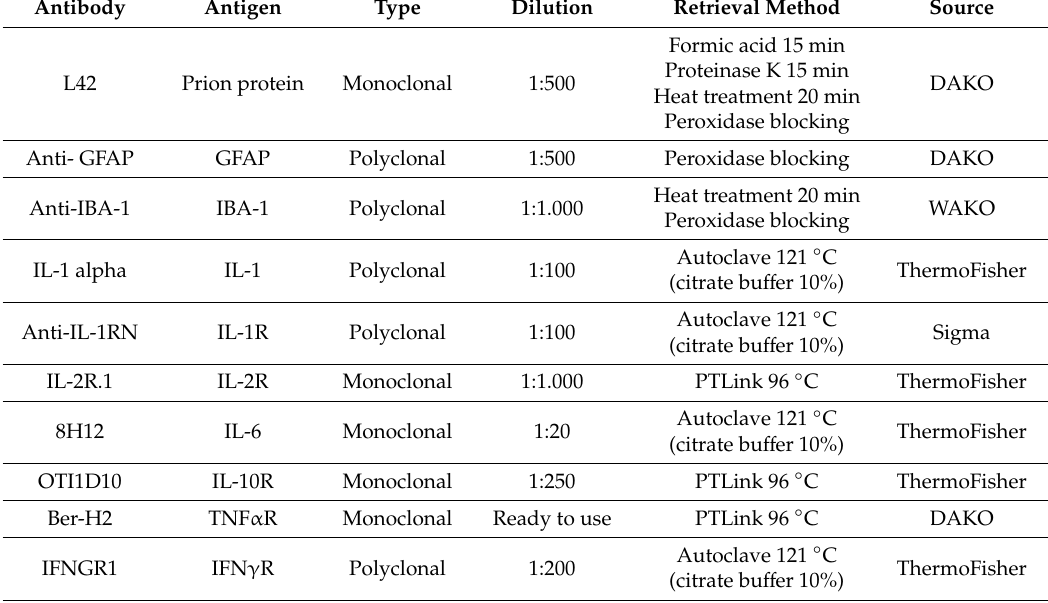
Table 3. Primary antibodies used for di ff erent immunohistochemical techniques and the retrieval methods applied for each of